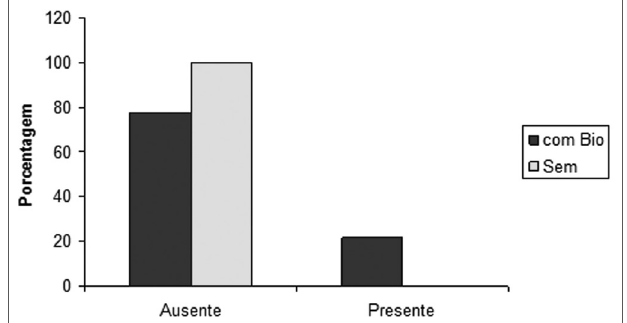
Figura 4. Porcentagem de animais que apresentaram ou não integri- dade do biomaterial, nos grupos controle (sem) e experimental (com Bio). (Prova de Fisher: p=0,462).